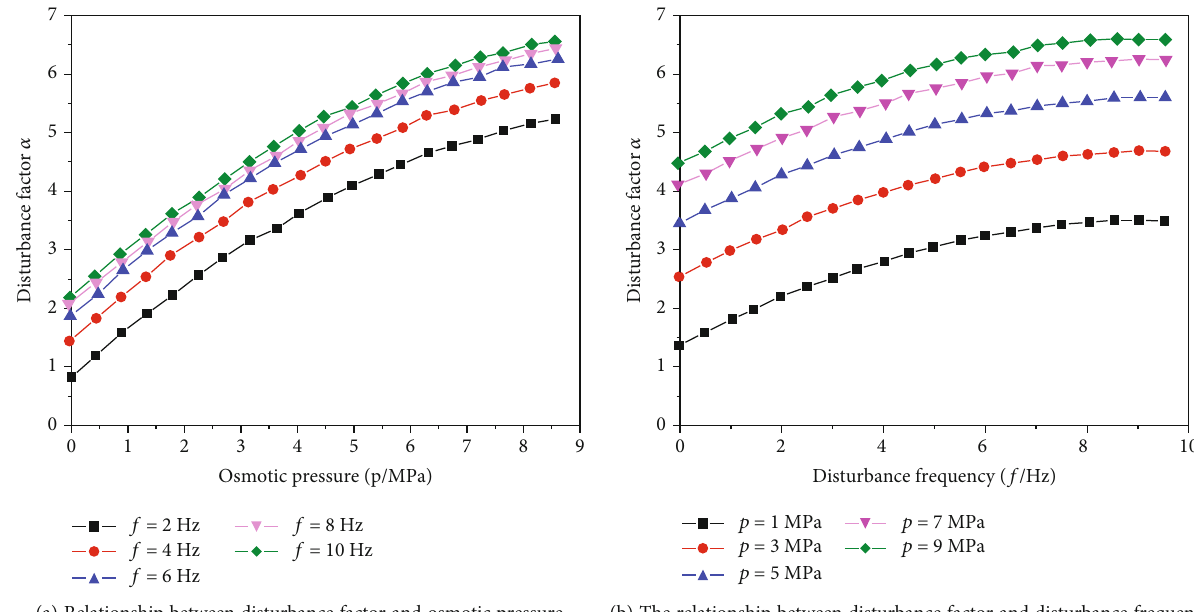
Figure 7: The in fl uence of p and f on the disturbance factor α .